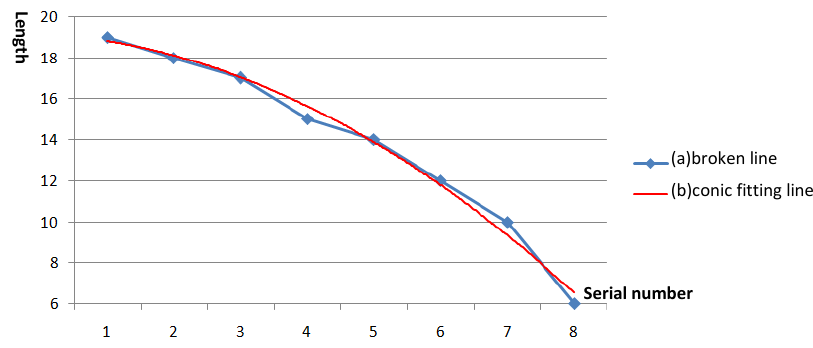
Figure 10. Graphical representation of the diagonal lines’ lengths of the V-shaped curve: ( a ) broken line; and ( b ) conic fitting line.